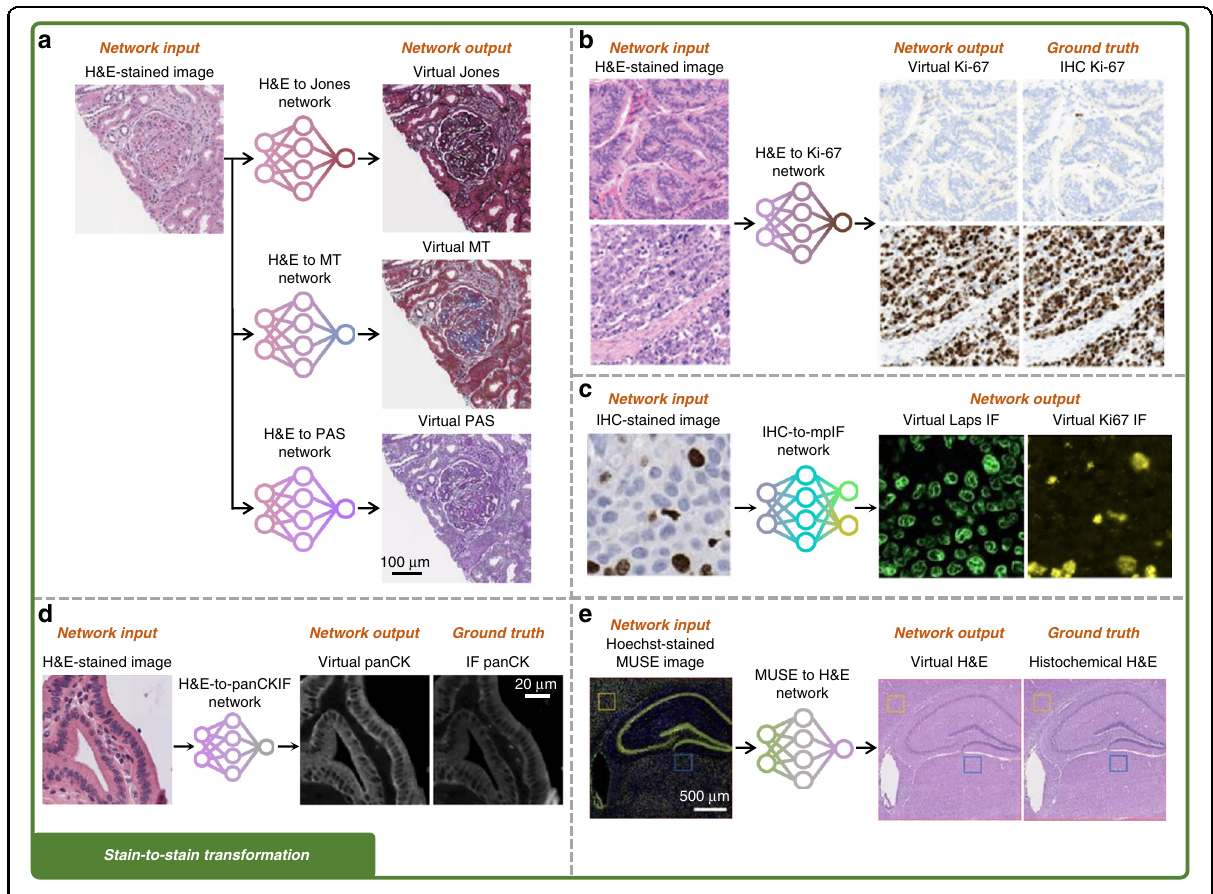
Fig. 5 Examples of virtual stain-to-stain transformations. a Transformation from H&E staining into virtual Jones silver, MT, and PAS staining 21 . b Transformation from H&E staining into virtual IHC Ki-67 staining 49 . c Transformation from Ki-67 IHC staining into multiplexed virtual IF staining 58 . d Transformation from H&E staining into virtual panCK IF staining 59 . e Virtual H&E staining using Hoechst-stained MUSE images 60 . Adapted with permission from ref. 60 © The Optical